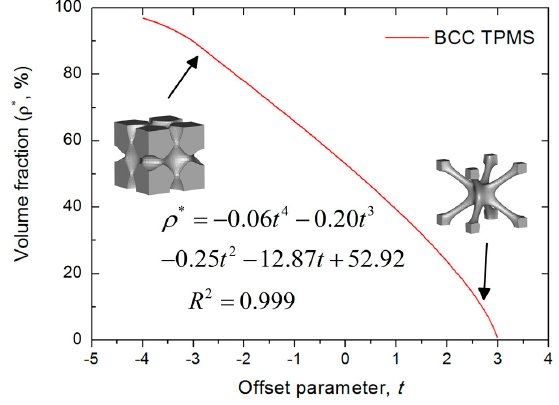
∗ ) and parameter t .